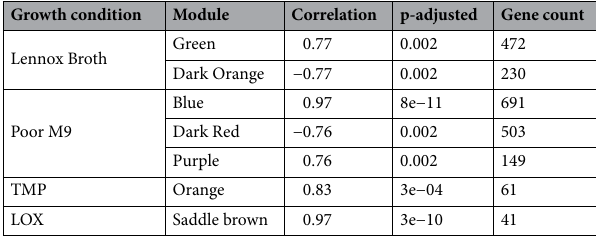
Table 2. Module summary.